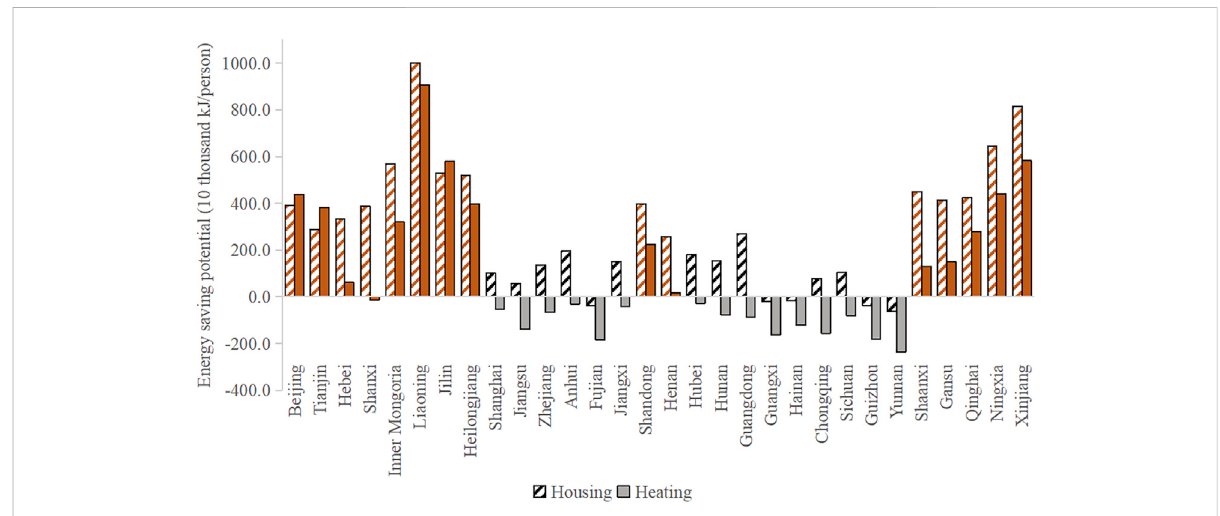
FIGURE 4 Energy saving potential of housing. The red bars represent the north of the Qinling-Huaihe